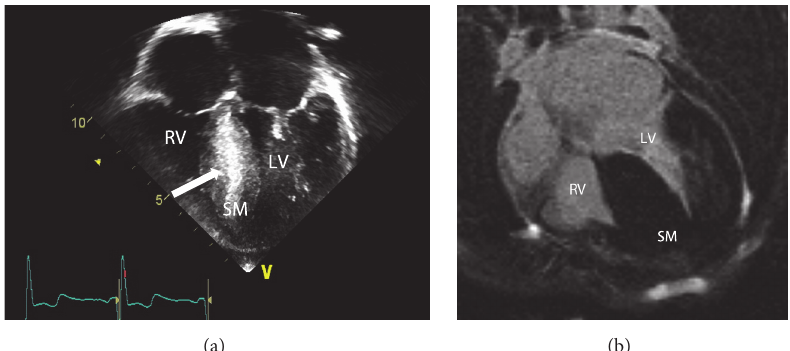
Figure 3: Sample images from echocardiography (a) and cMRI (b) performed on an 8-year-old male patient with HCM demonstrating a false positive result on echocardiography. (a) demonstrates increased echogenicity of the septal myocardium (white arrow) with no corresponding abnormality seen at cMRI; note the homogeneous signal of the septal myocardium. (RV: right ventricle, LV: left ventricle, and SM: septal myocardium).